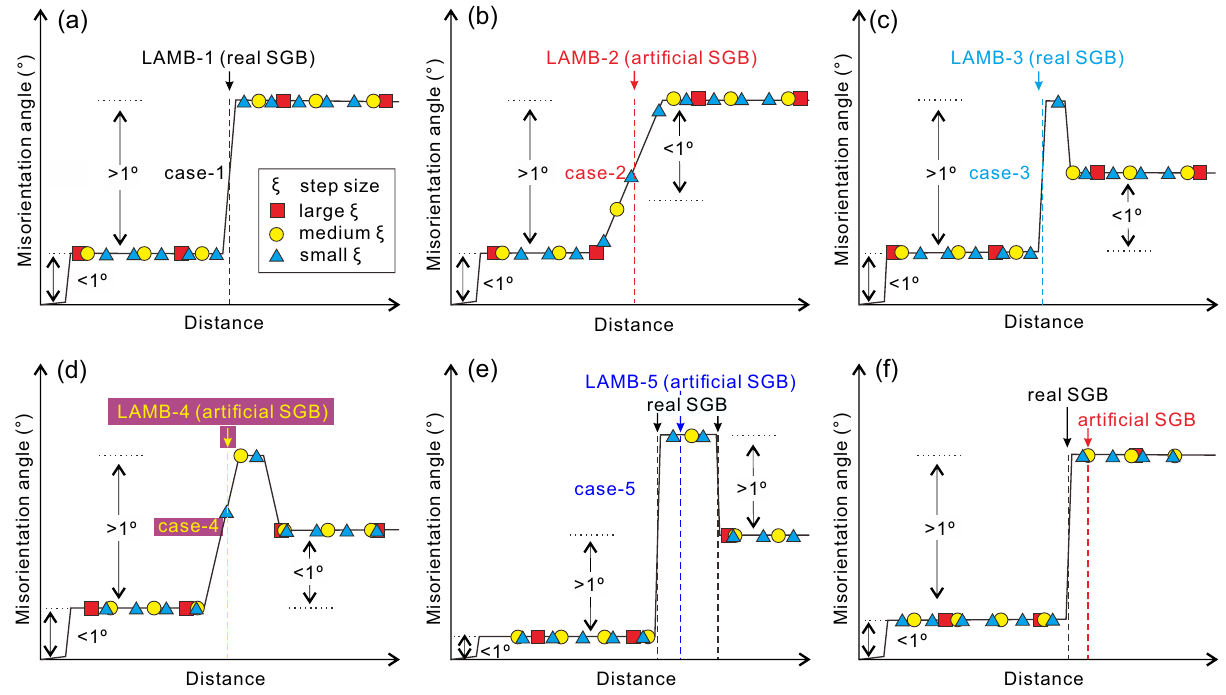
Figure 7. Schematic diagrams explaining the formations of five observed LAMBs ( a – e ) and another case ( f ) with the variation of EBSD mapping step size. A misorientation threshold of 1° between adjacent pixels is used to define LAMB (colored vertical dashed lines)